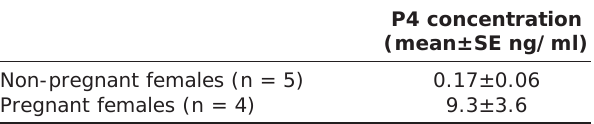
Table-1: P4 concentrations (mean±SE) obtained by ECL systems in non-pregnant and pregnant females.